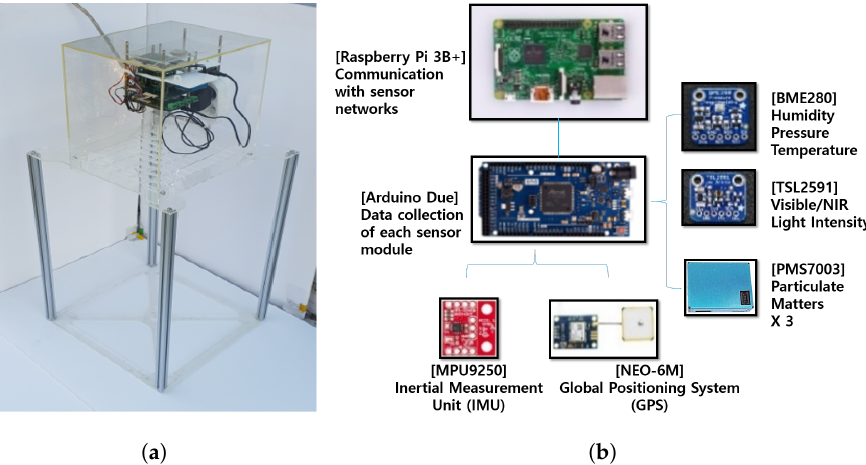
Figure 3. Information on multi-sensor platform. ( a ) Picture of platform; ( b ) Configuration of